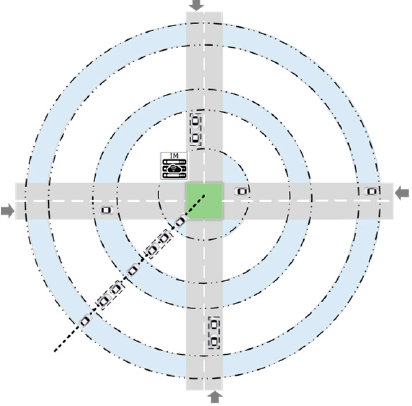
Figure 6. Virtual platoon projection.